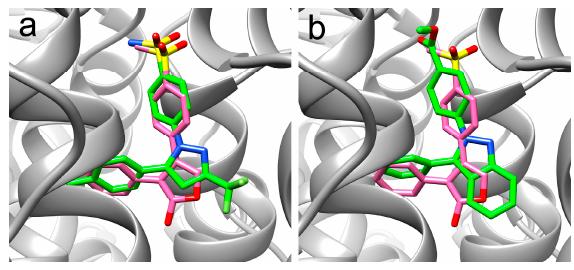
Figure 2. Predicted binding modes on human COX-2 for celecoxib (panel a) and 18 (panel b). Docked compounds are shown in green, whereas the crystallographic reference rofecoxib is in pink.